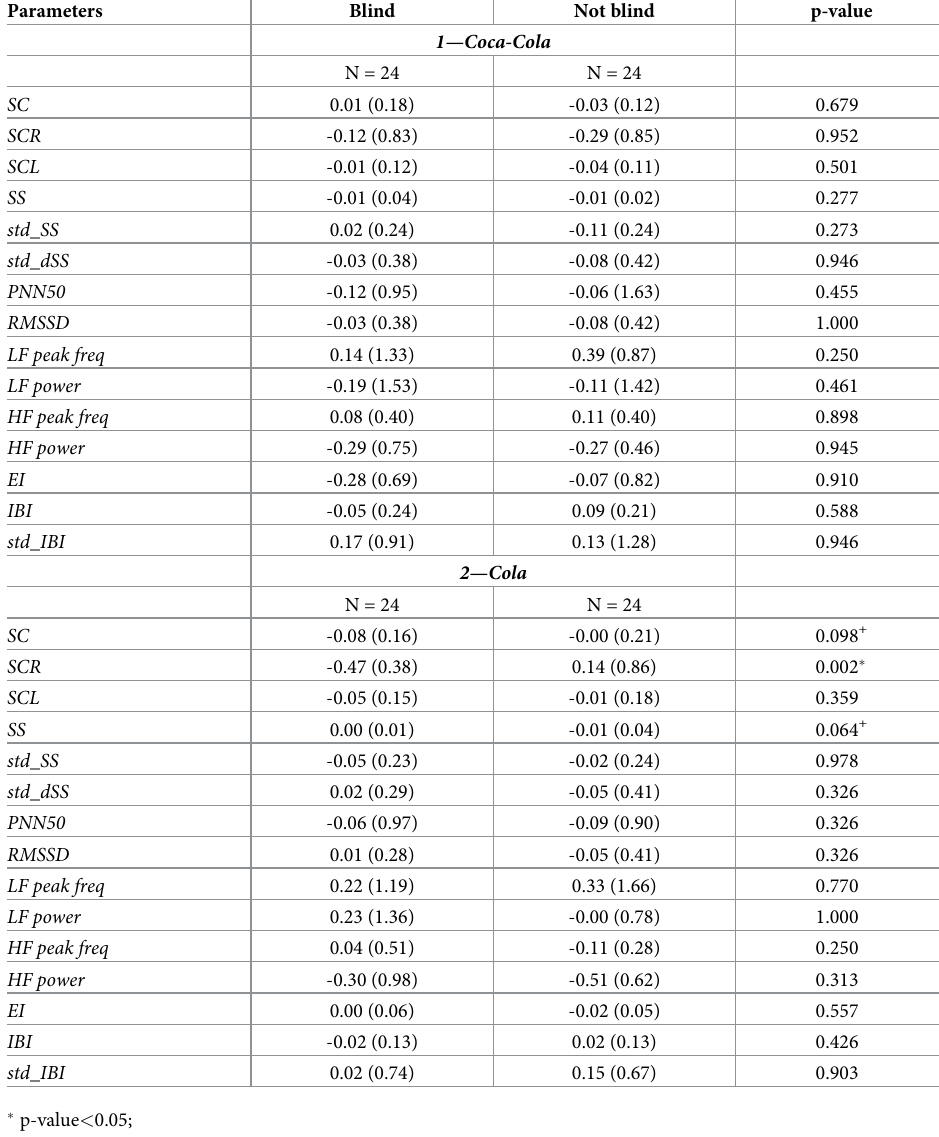
Table 1. Comparison between B and NB conditions.